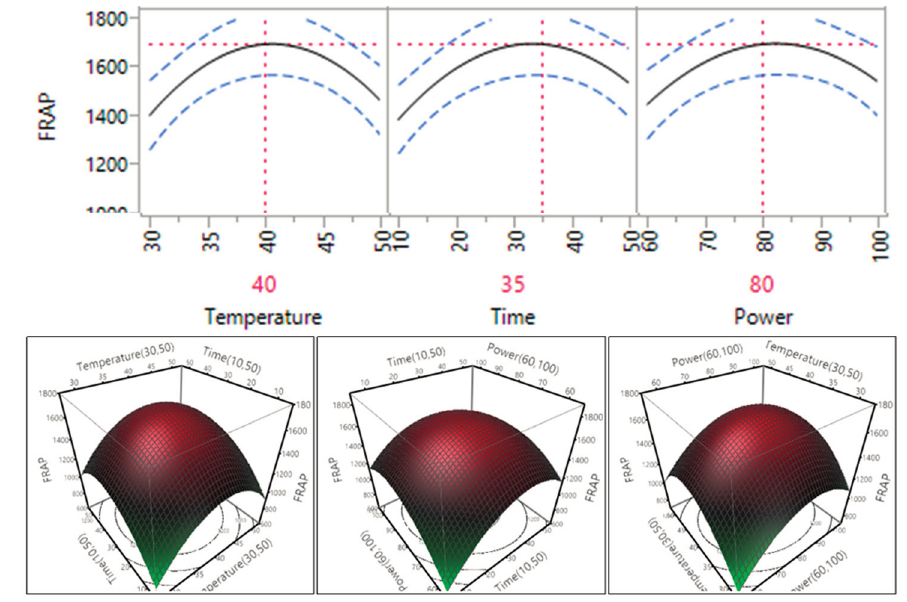
Figure 10. Impact of temperature (60–90 °C), time (10–30 min) and power (60%–100%) on